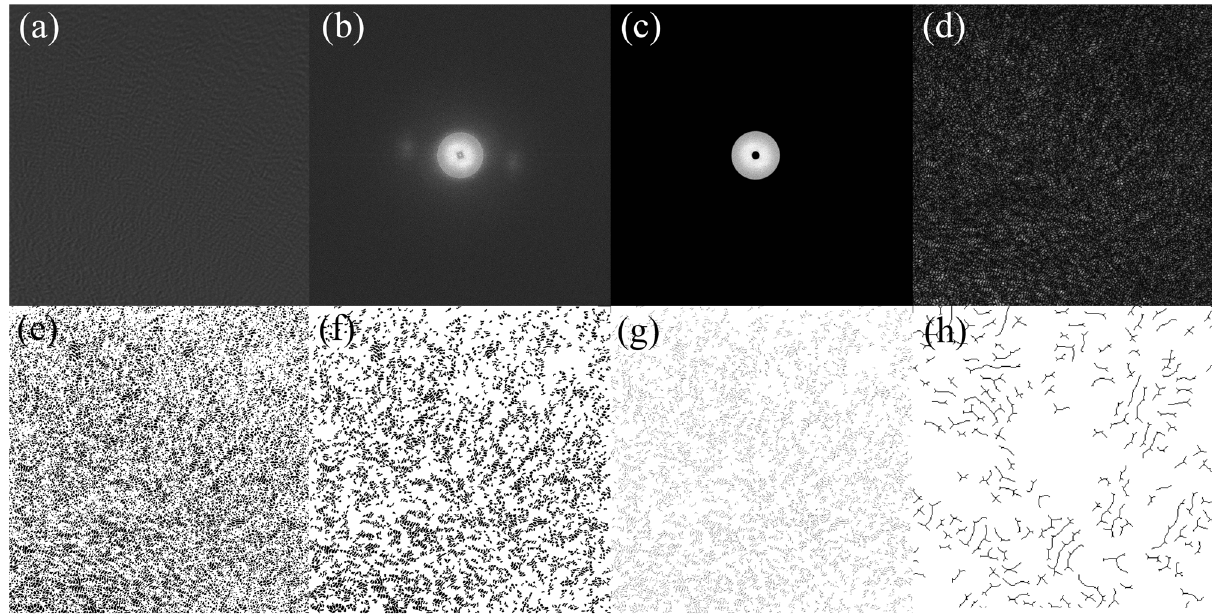
Figure 1. Diagram of image processing on lattice image of coal ( a ) Original image, ( b ) FFT image, ( c ) Loop filter, ( d ) IFFT image, ( e ) Figure of Binarization, ( f ) Figure of Skeletonization, ( g ) Figure of Vectorization, ( h ) Partial enlarged detail of Figure vector